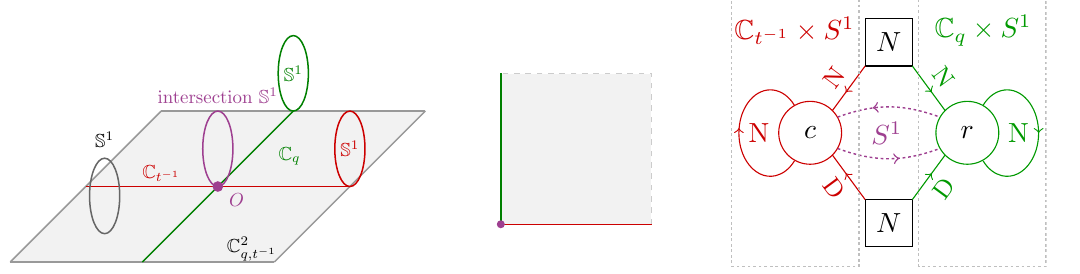
1 and its q;t (cid:0) 1 (cid:2) S S 1 C 2 q;t S 1 . (cid:2) (cid:26) (cid:0) 1 (cid:2)